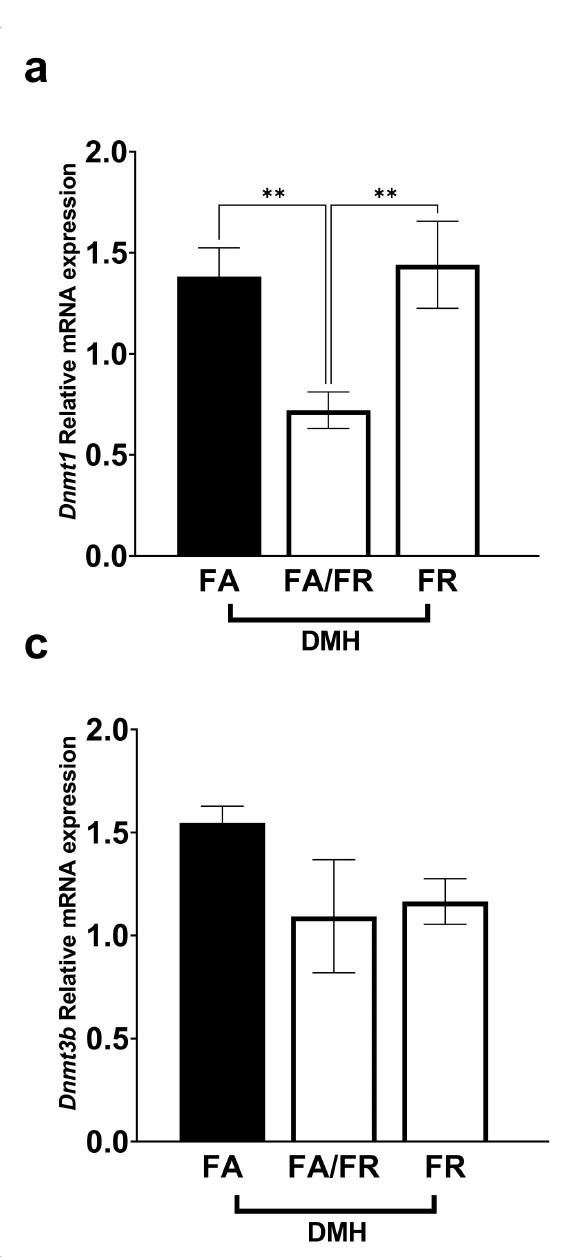
Figure 4. Folate restriction alters DNA methyltransferase expression in the liver of DMH-treated C57BL/6 mice. ( a ) Dnmt1 relative mRNA expression. ( b ) Dnmt3a relative mRNA expression. ( c ) Dnmt3b relative mRNA expression. Real-time expression data was normalized to geometric mean of Gapdh and Rplp0 . FA = folate adequate diet, FA/FR = folate adequate diet followed by initiation of folate-restricted diet one week prior to DMH injections, FR = folate-restricted diet. n = 6–7, Bars, S.E.M, * p < 0.05, ** p <